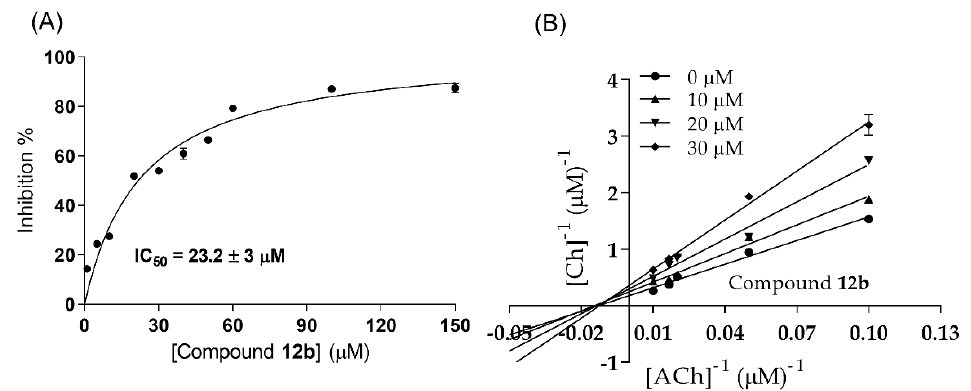
Figure 3. Dose-response inhibition curve ( A ) and Lineweaver−Burk reciprocal plots ( B ) for com- pound 1 BChE hu -ICER using the on-flow dual parallel enzyme assay. Results obtained from three independent experiments (n = 3) expressed by mean ± SEM.